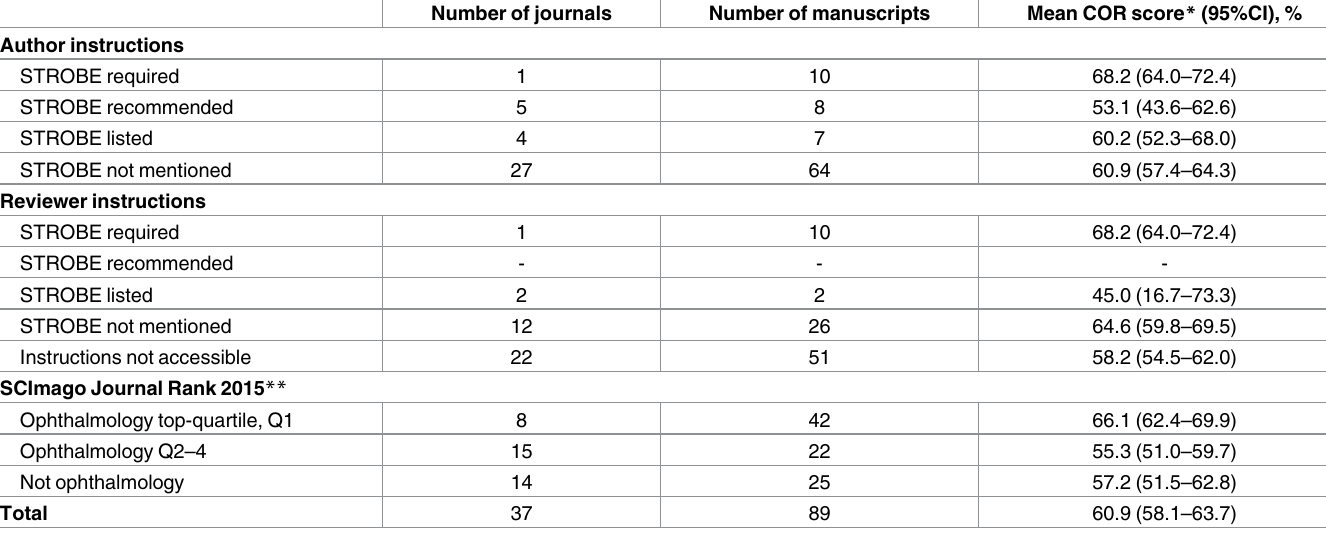
Table 1. Completeness of reporting (COR) score for journals publishing prevalenceof blindness studies, by inclusion of STROBE in instructions for authors and reviewers,and ophthalmology SCImago Journal